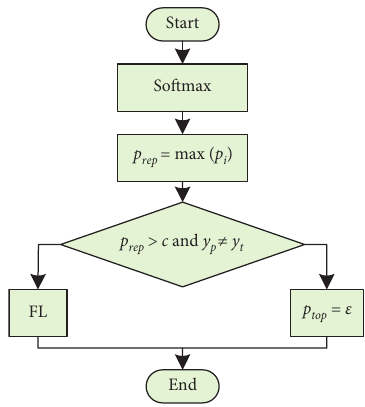
Figure 4: Flow chart of improved FL